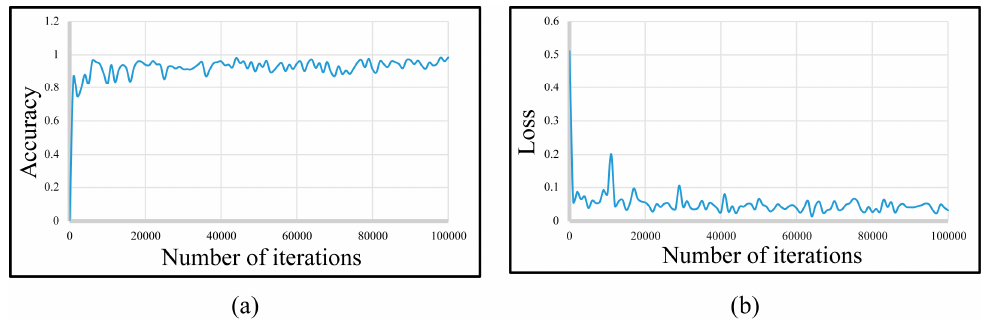
Figure 6. Plots showing the accuracy ( a ) and loss ( b ) of the GL-Dense-U-Net model while training the datasets with increasing iterations.